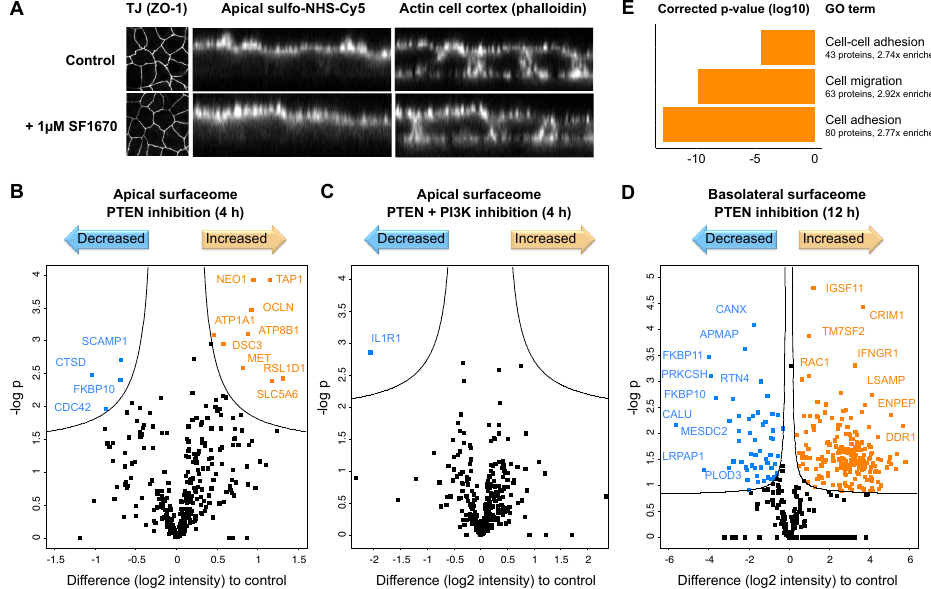
Figure 5. Impaired PTEN function impacts the polarized surfaceome. ( A ) Representative confocal microscopy images of filter-grown MDCK cells showed intact cell layer integrity upon PTEN inhi- bition by 1 µ M SF1670, with no effect on the expression of the tight junction (TJ) protein ZO-1 (left panel) nor on the side-specific cell surface labeling with an NHS-conjugate (center panel). Staining of the actin cell cortex by phalloidin was used as a reference for cellular localization (right panel). ( B ) Label-free quantification of apical surface proteins upon PTEN inhibition by 1 µ M SF1670 for 4 h revealed alterations in protein abundance. ( C ) Simultaneous PTEN and PI3-kinase inhibition by 1 µ M SF1670 and 1 µ M LY294002, respectively, diminished the effect. ( D ) PTEN inhibition caused substan- tial quantitative changes in the basolateral surfaceome composition. Proteins with a significantly altered abundance compared with the control are marked in orange (increased) and blue (decreased) ( n = 3, two-sided t -test FDR = 0.05, s0 = 0.1). ( E ) Gene ontology analysis of basolateral proteins